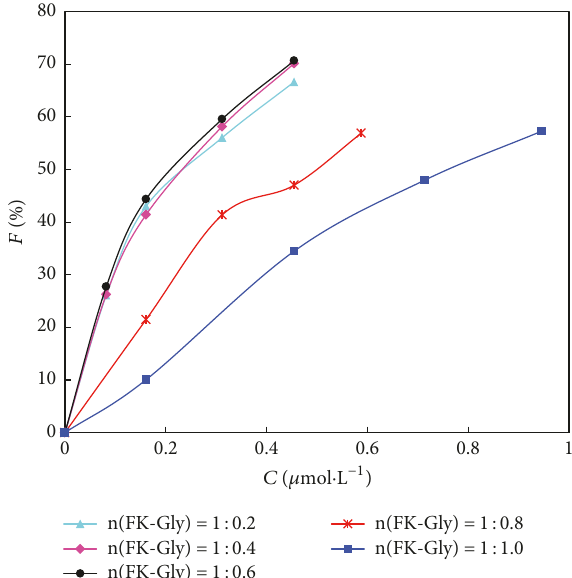
Table 4: EC 50 of FK-Gly at different mounts of Gly.